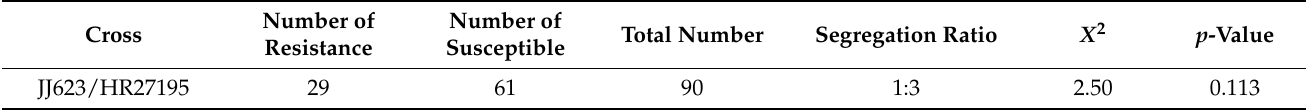
Table 2. Genetic analysis of the resistance response using lesion length for pathotype of Xoo K3a, a bacterium that induces BB of the F 2 line derived between JJ623 and HR27195.